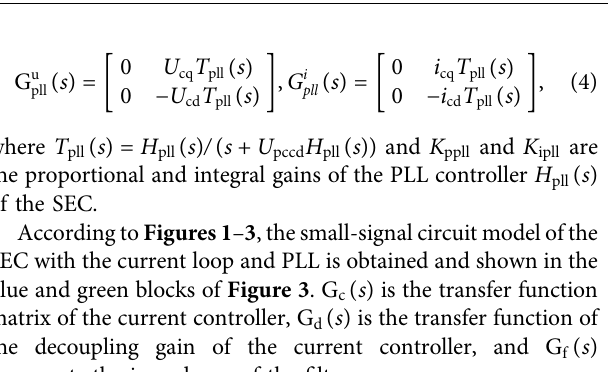
FIGURE 3 | Small-signal circuit model of the sending-end station of